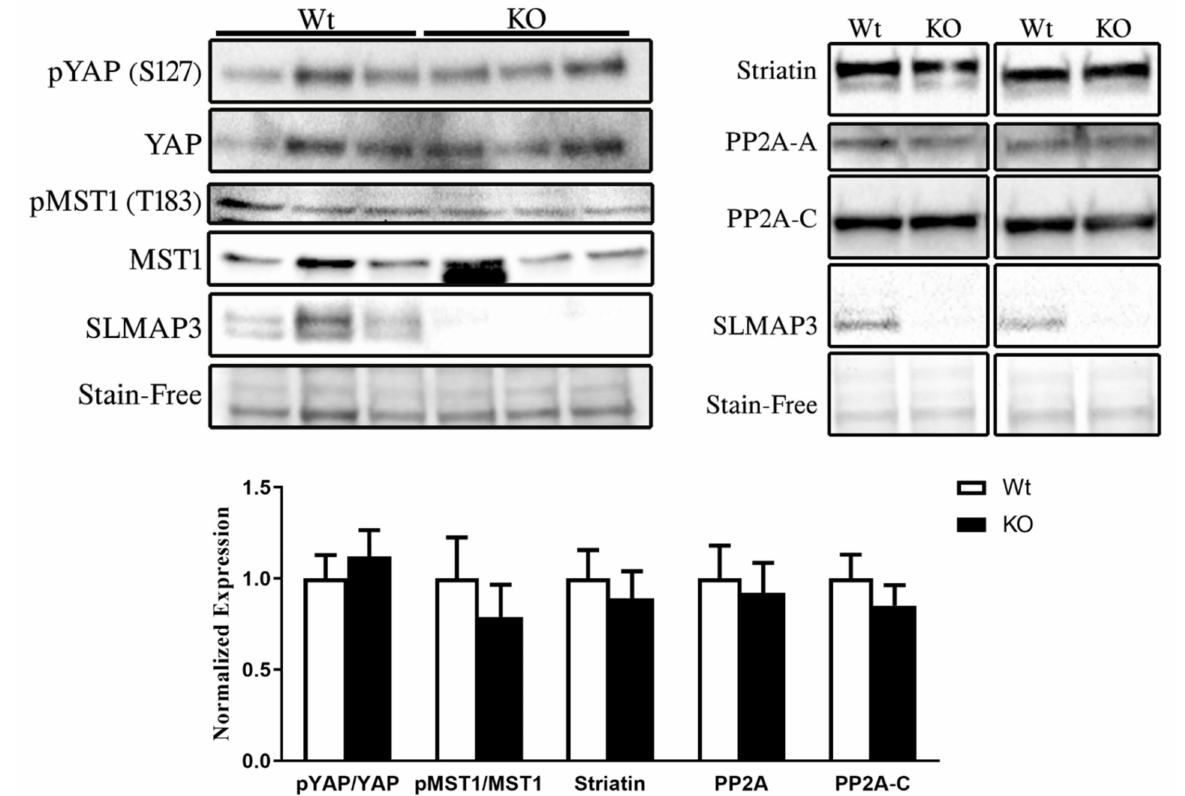
Figure 9. STRIPAK complex and Hippo signaling in SLMAP3-KO hearts. Western blot of Wt and KO adult mouse heart lysates evaluating protein expression STRIPAK components (striatin, PP2A-A and PP2A-C) and phosphorylation of MST1 (T183) and YAP (S127). Bar graphs represent the expression of indicated proteins by normalizing with total protein visualized by Stain-Free as a loading control or to total MST1 or total YAP. n =